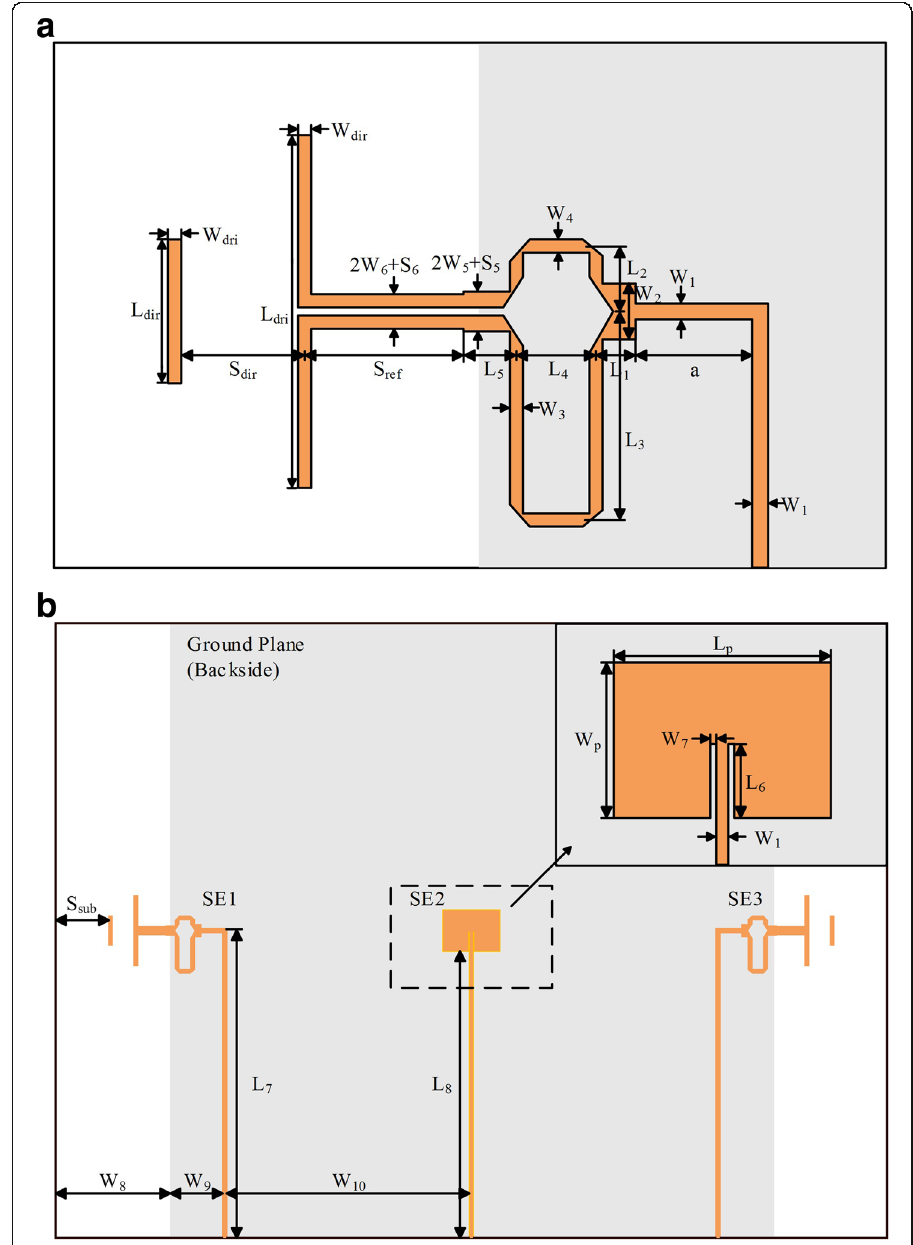
Fig. 5 Structure of the radiating element. a Details of the Yagi-Uda antennas. b Schematic of the radiating element with details of the patch antenna, SE1-SE3 denote radiating